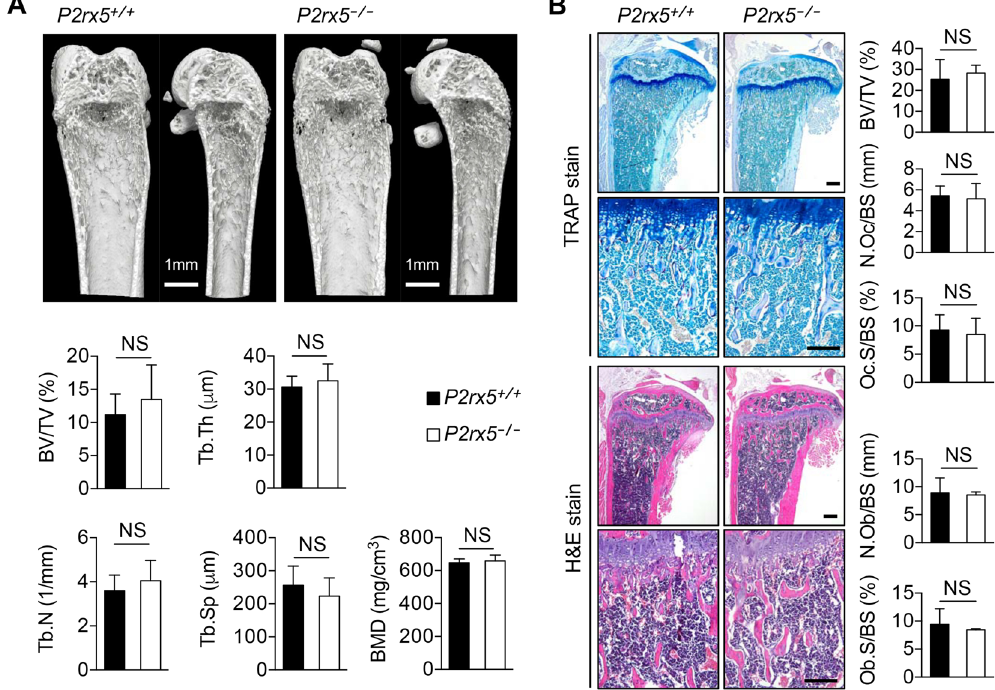
Figure 5. Normal bone development and homeostasis in P2rx5 − / − mice. ( A ) Representative 3D reconstructions of trabecular bone. The tibias of 8-week-old male P2rx5 + / + and P2rx5 − / − littermate mice were analyzed by μ CT scanning. Calculations of bone volume per tissue volume (BV/TV), trabecular thickness (Tb.Th), trabecular number (Tb.N), trabecular space (Tb.Sp) and bone mineral density (BMD) are shown. Scale bar, 1mm. NS, not significant. Data are means ± SD. ( B ) Histomorphometric analyses, representative TRAP staining (upper panel) and H&E staining (lower panel). Also shown are BV/TV, osteoclast number per bone surface (N.Oc/BS), OC surface per bone surface (Oc.S/BS), osteoblast number per bone surface (N.Ob/BS) and osteoblast surface per bone surface (Ob.S/BS). Scale bar represents 100 μ m. NS, not significant. Data are means ±